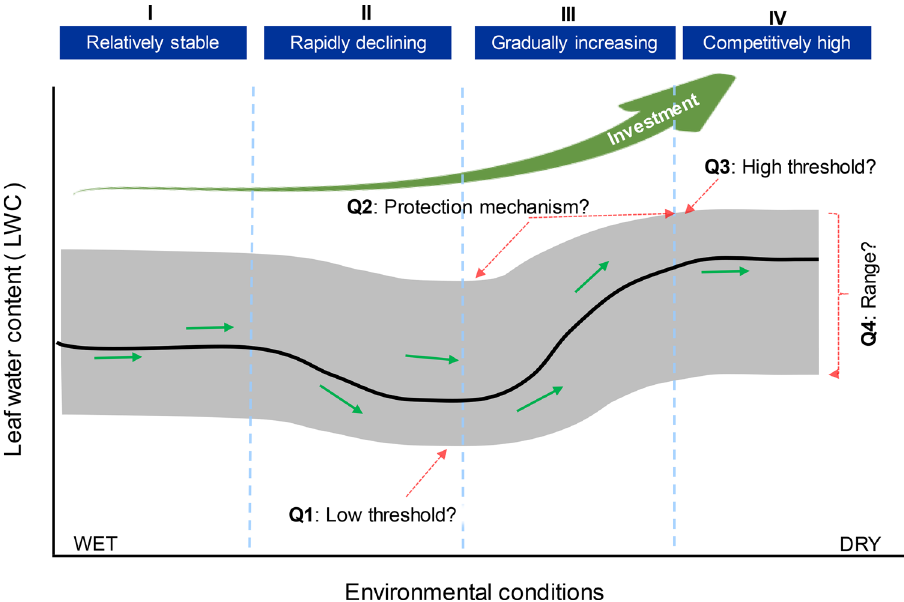
Figure 6. Underlying mechanism for spatial variation in leaf water content (LWC) among environmental gradients (investment vs. competition mechanism). LWC was relatively stable, with plants that are stabilized with low investment for water retention (I); LWC declined rapidly and stabilized, with the water conservation mechanism gradually forming to enhance moisture retention, while investment gradually increased (II); LWC gradually increased as a result of high investment and community competitive advantage (III); in phase IV, plants built the highest LWC with the highest investment. Four questions (Q1–Q4) require exploring in the of